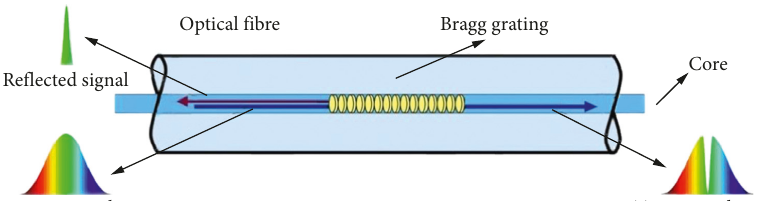
Figure 1: Working mechanism of an FBG